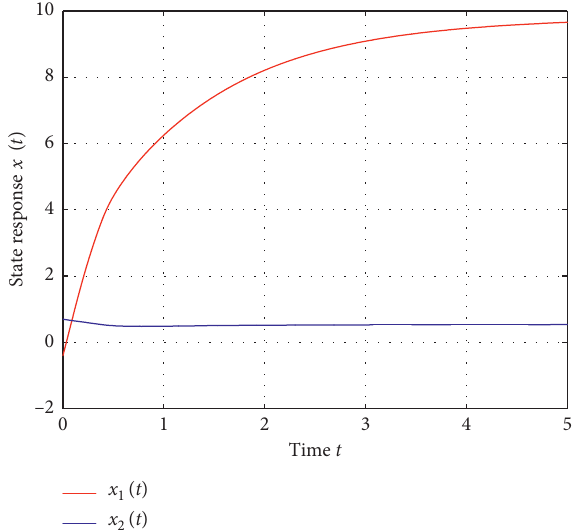
Figure 7: Curve of x ( t ) without control for Example 2.